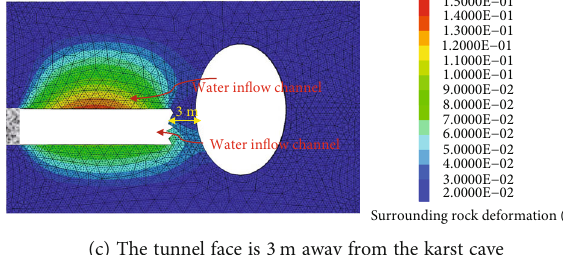
Figure 5: Deformation characteristics of surrounding rock under di ff erent thickness of water-resisting